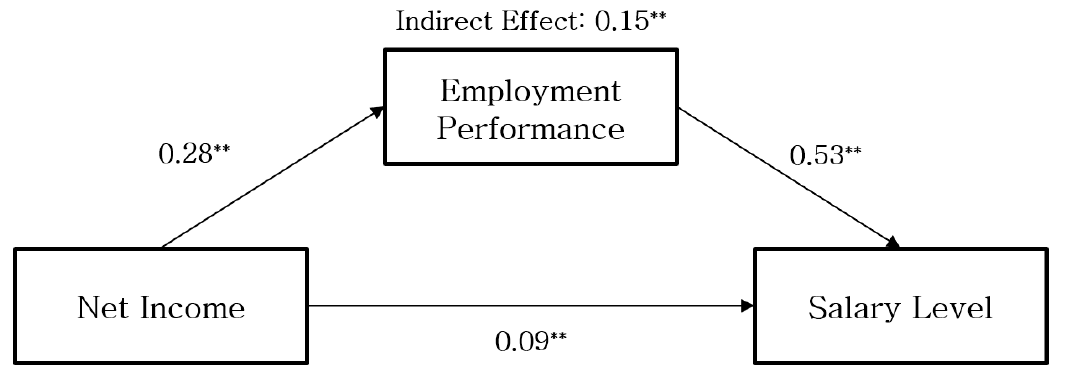
Figure 4. Mediation effect of employment performance.